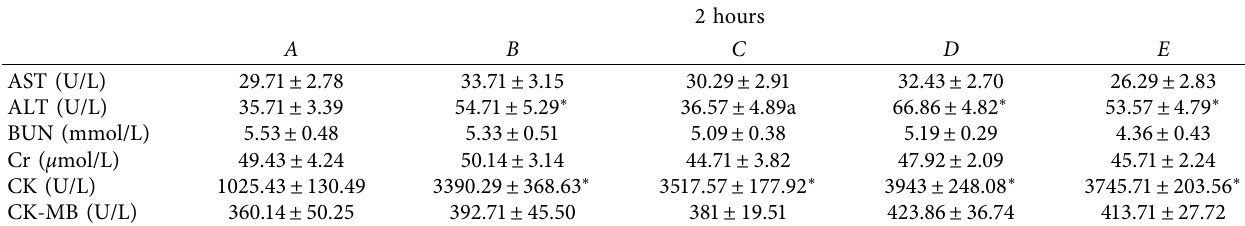
Table 1: Outcomes of blood biochemical analysis in rabbits 2 hours after the injection with Naja atra